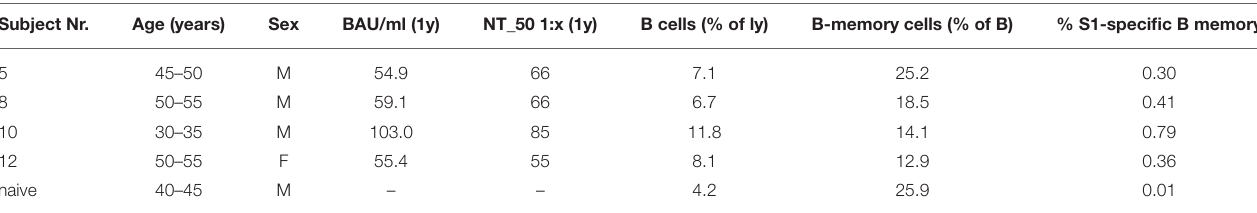
TABLE 1 | S1-specific IgG in BAU/ml, NT_50 titers and respective percentages of B-cells, B memory cells and S1-specific B memory cells quantified by flow-cytometry for four COVID-19 convalescent subjects and one SARS-CoV-2 naïve control; y, year; ly, lymphocytes.